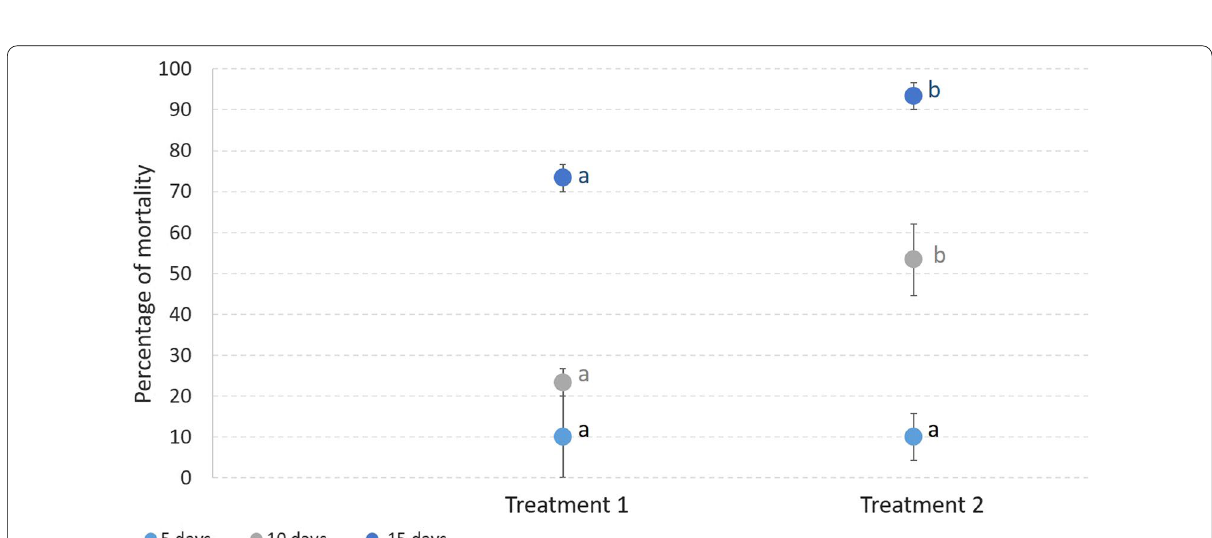
Fig. 3 Percentage of mortality of nymphs of Bufonacris claraziana treated with different baits containing Beauveria bassiana conidia at 5, 10, and 15 days after treatment. Different letters showed significant differences (LSD Fisher p <